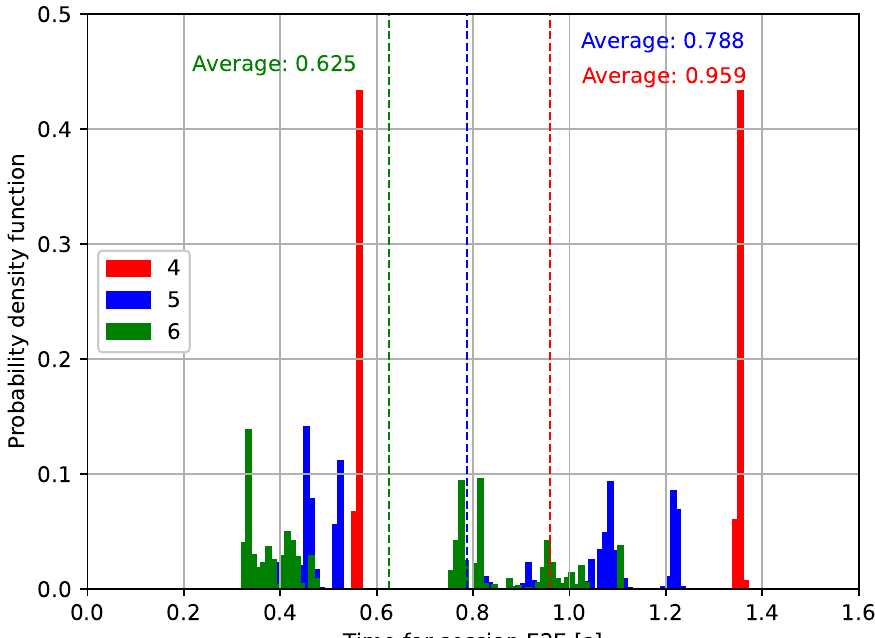
Figure 6. Time required to establish an entanglement